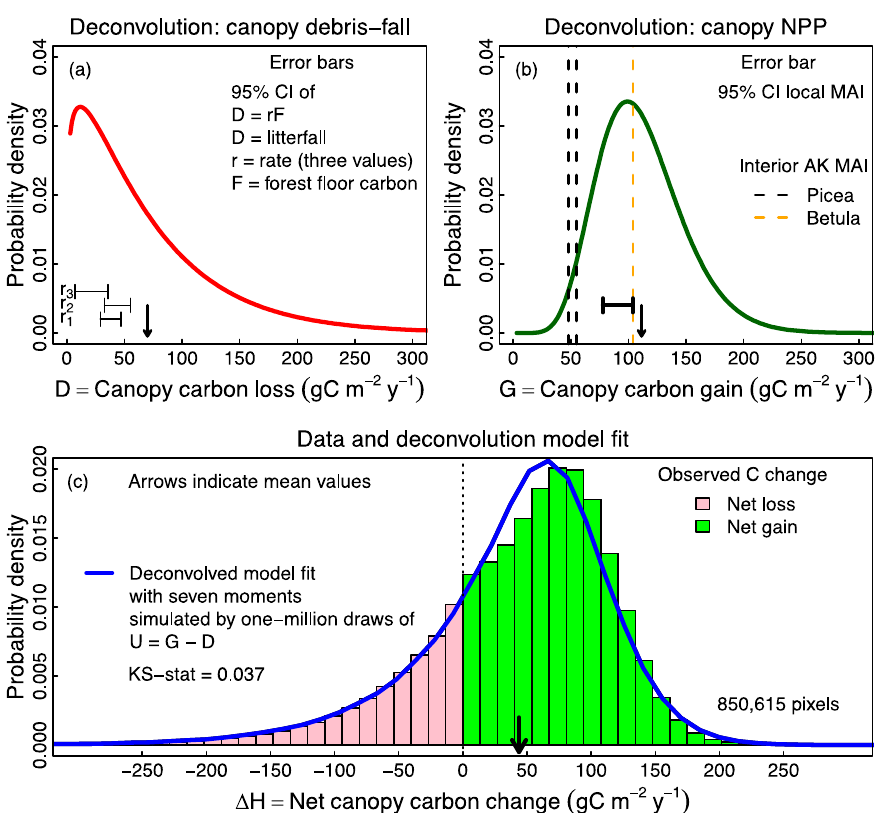
Figure 1. Deconvolution of observed average net change in canopy carbon as unobserved canopy carbon loss (carbon loss through debris-fall) and unobserved canopy carbon gain (carbon gain through above ground Net Primary Productivity; NPP) with a 7-moment fit of their difference (blue distribution) superimposed on the histogram of observed net change in canopy carbon from lidar-assisted carbon model. The fit is poor as expected because the landscape is heterogeneous. ( a ) Gamma distribution of D interpreted as canopy carbon loss. Error bars show 95% CI of independent estimates of canopy carbon loss using measured decomposition rates of logs in three decay phases (r 1 : under 30% decomposed, r 2 : 30-70% decomposed, r 3 : 70% or more decomposed) [32] and measured coarse woody debris plus litter on the forest floor of the study area. ( b ) Gamma distribution of G interpreted as canopy carbon gain. Vertical lines give mean annual increment (MAI = stand biomass/stand age) for three Interior Alaska boreal forest sites [33]. Error bar gives 95% CI for MAI = mean [tree biomass/tree age]*(number of trees/plot) averaged over n = 59 plots in the study area. ( c ) Observed histogram of all pixels giving differences in carbon between two lidar estimates of biomass separated by 13 years with best deconvolved model fit as difference in distributions given in ( a ) and ( b ). Pink boxes tally observed pixels with net canopy carbon loss; green boxes tally pixels with net canopy carbon gain. KS ‐ stat = Kolmogrov Smirnoff statistic as described in text indicating a rather poor fit, visible in the figure.